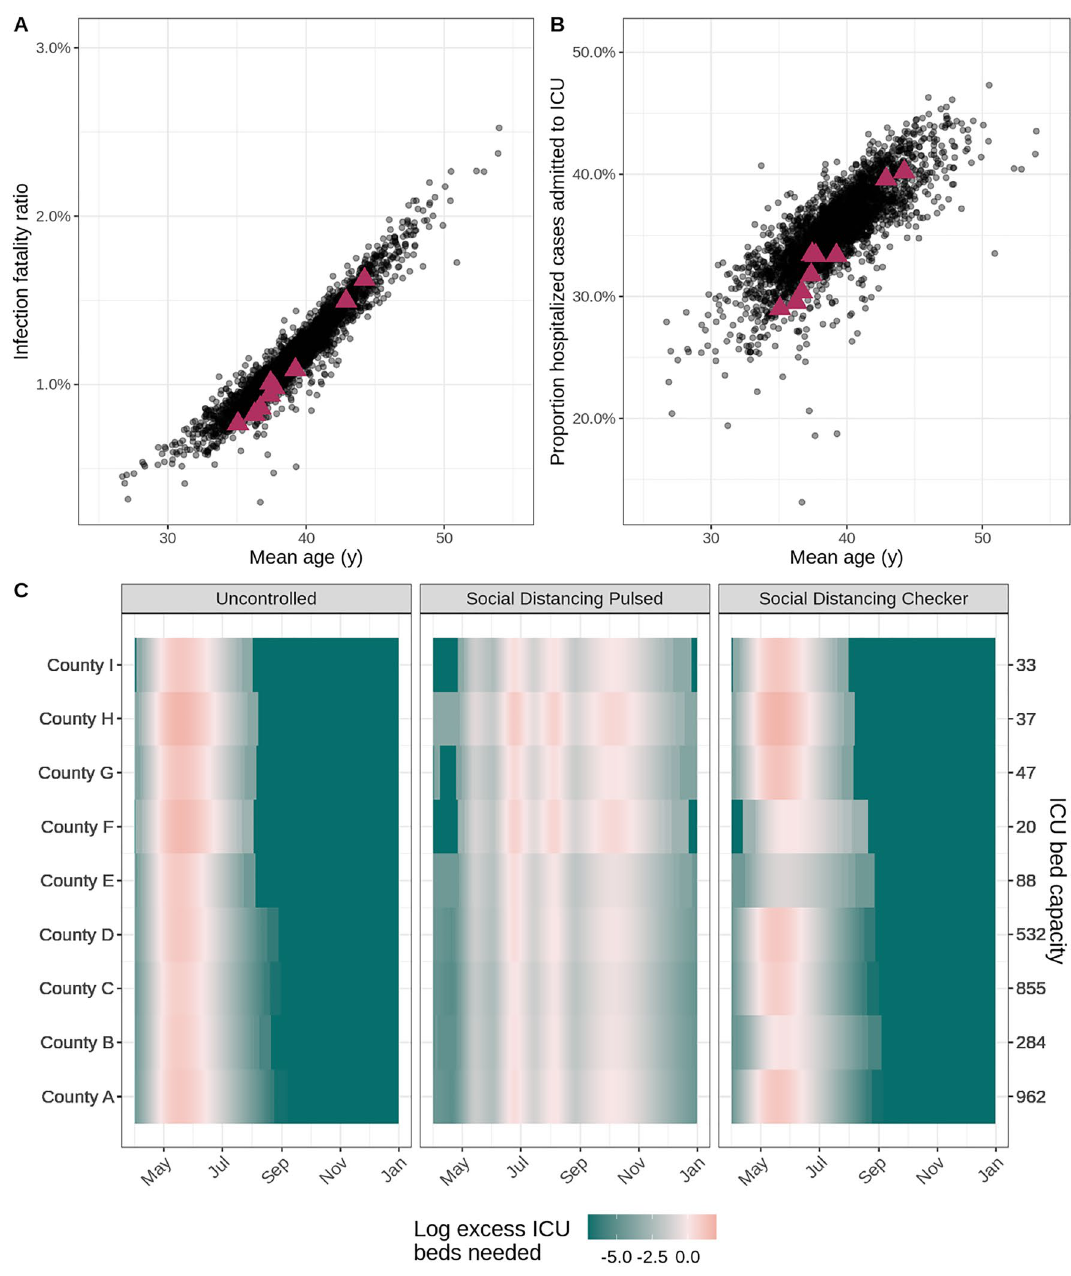
Figure 3. Health outcome risks and logistical needs for fictional counties. In the scatterplots, each point indicates ( A ) the age-adjusted infection fatality ratio and ( B ) risk of ICU admission given hospitalization by mean age for a county within the United States. Data for the nine fictional counties in our vignette is marked by magenta triangles. ( C ) The heat maps display county-level ICU bed needs, shaded according to the log ratio above or below the assumed ICU bed capacity (secondary y-axis) in each county (primary y-axis) for three example intervention scenarios (panels). The salmon pink shading indicates periods of time where ICU bed needs exceed capacity in the fictional